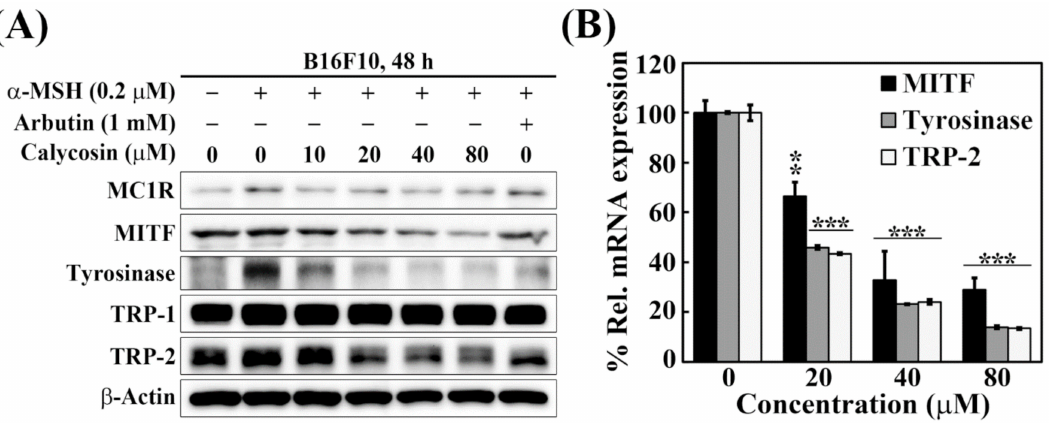
Figure 3. Calycosin inhibits the expressions of MITF, Tyrosinase, and TRP-2 in B16F10 cells. ( A ) Western blot analyses of the dose-dependent effect of calycosin on the expression levels of MC1R, MITF, Tyrosinase, TRP-1, and TRP-2 in B16F10 cells treated with 0.2 µ M α -MSH and indicated concentrations of calycosin for 48 h. The values denote fold changes was determined by the relative intensity of protein bands of treated samples to that of the respective vehicle-treated control after normalization to the respective internal reference β -actin. ( B ) Quantitative real-time PCR analyses of the effect of calycosin on mRNA expressions of MITF, Tyrosinase, and TRP-2 in B16F10 cells treated with 0.2 µ M α -MSH and indicated concentrations of calycosin for 48 h. Significant difference versus control: ** p < 0.01, *** p <